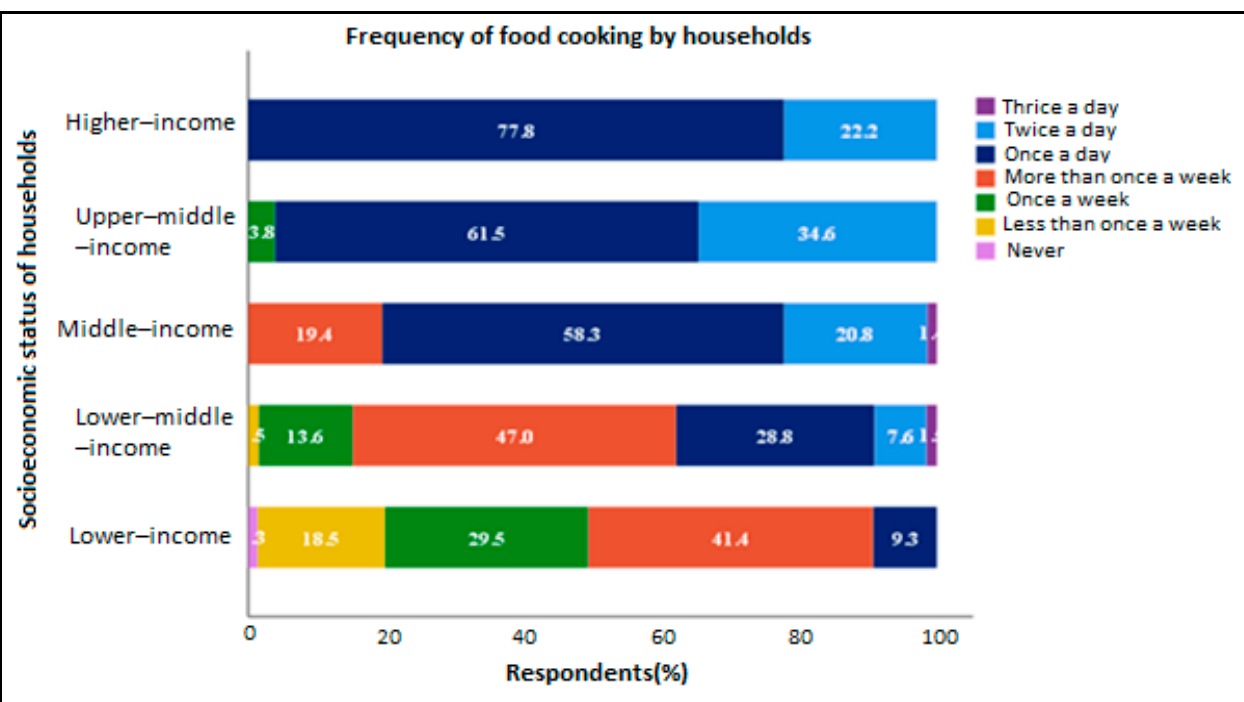
Table 5. Relationship between frequency of cooking at home and storage of cassava and plantain.